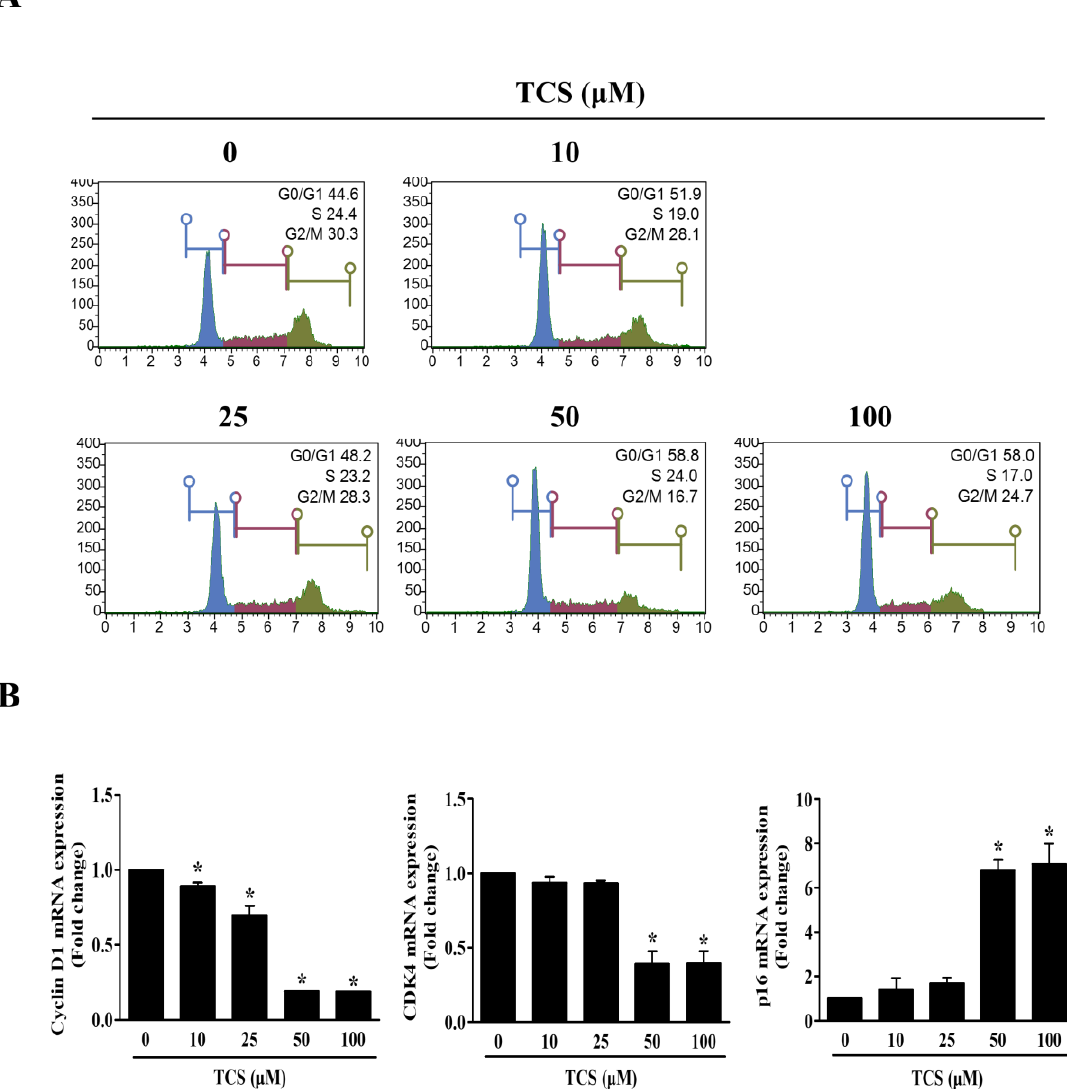
Figure 5. TCS causes G0/G1 phase arrest by regulating expression of cyclin D1, CDK4, and p16. ( A ) Cell cycle analysis of TCS-treated CT26 cells for 48 h. ( B ) mRNA expressions of cyclin D1, CDK4, and p16. Results are represented as the mean ± SD of three independent experiments. * p <